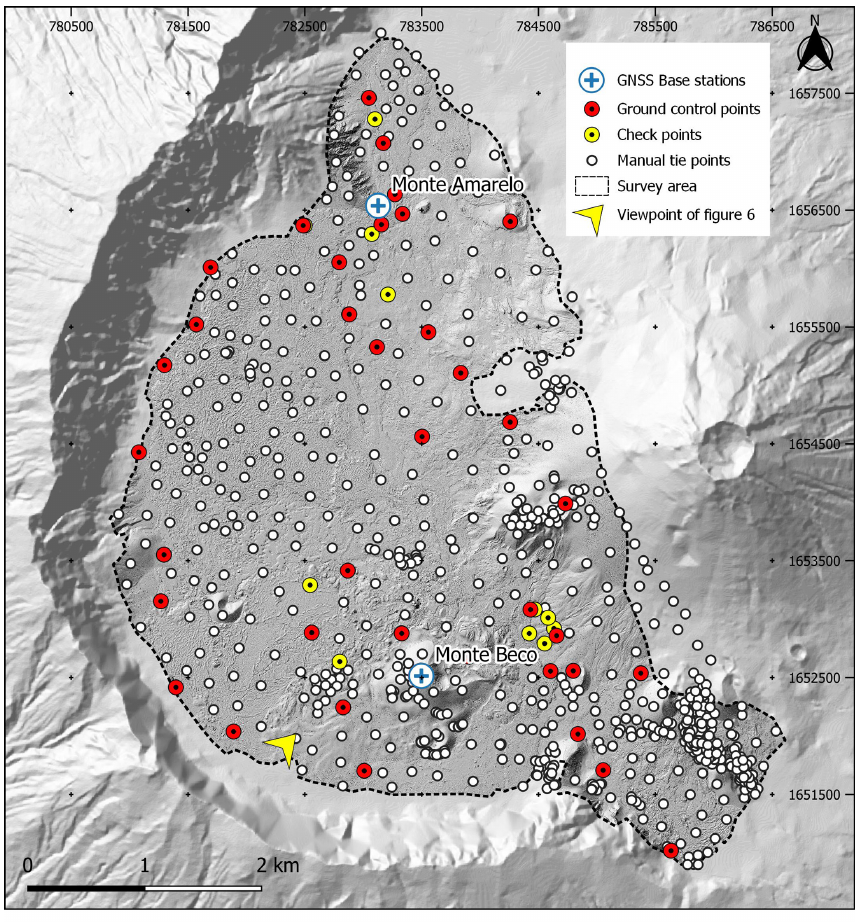
Figure 5. Ground control points used for the model and for the accuracy evaluation (checkpoints), manual tie points used to improve the point cloud accuracy and location of the GNSS base stations set up for collecting the ground control points and tie points. Shaded relief outside the survey area from the DEMFI (2010) 5m